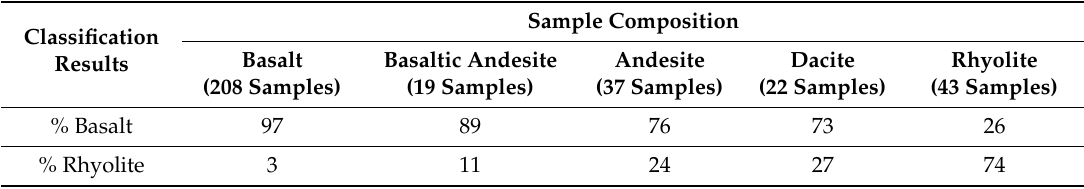
Figure 11. The vast majority of the Alarcon Rise was correctly classified as basaltic (light shading, top panel), with a rhyolitic signature (white outlines) dominantly in the north. Inset of the North AOI (red box) shows the majority of rhyolitic samples correctly classified with a rhyolitic fingerprint along with some intermediate samples classified as rhyolitic. The class break was chosen at a value of 1.7 because 75% of rhyolitic samples and only 3% of basaltic samples were classified with values equal to or above 1.7. Table 3. Normalized percent of pixels assigned by classification for known sample lava